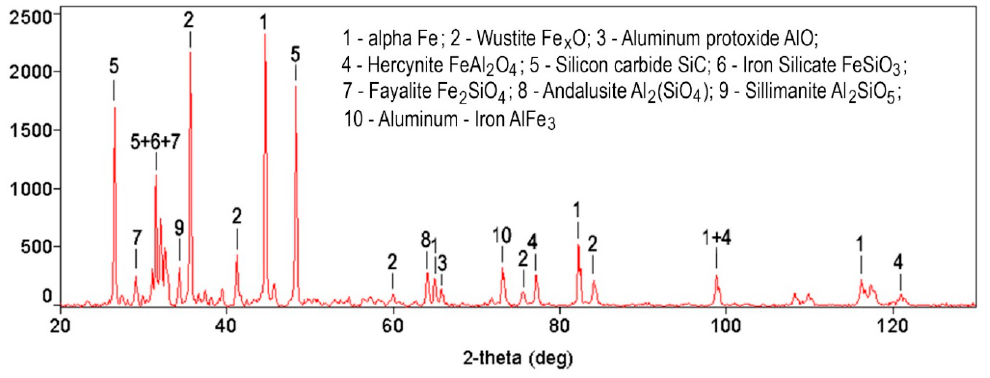
Figure 3. Chemical compounds formed in the FeGr1 + C + Al 2 O 3 + SiC composite.